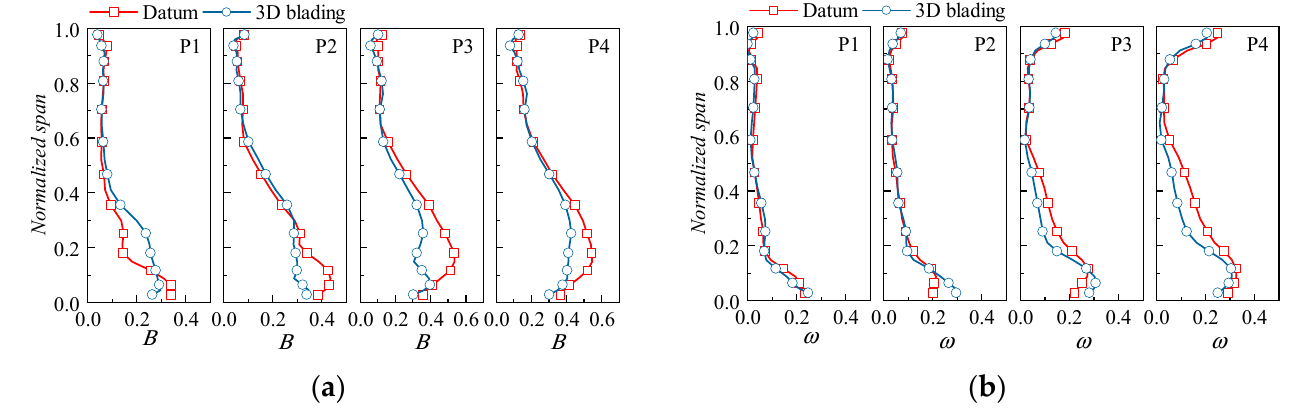
Figure 34. The radial distribution of blockage and loss under different operating coefficients: ( a ) blockage; ( b ) total pressure loss.